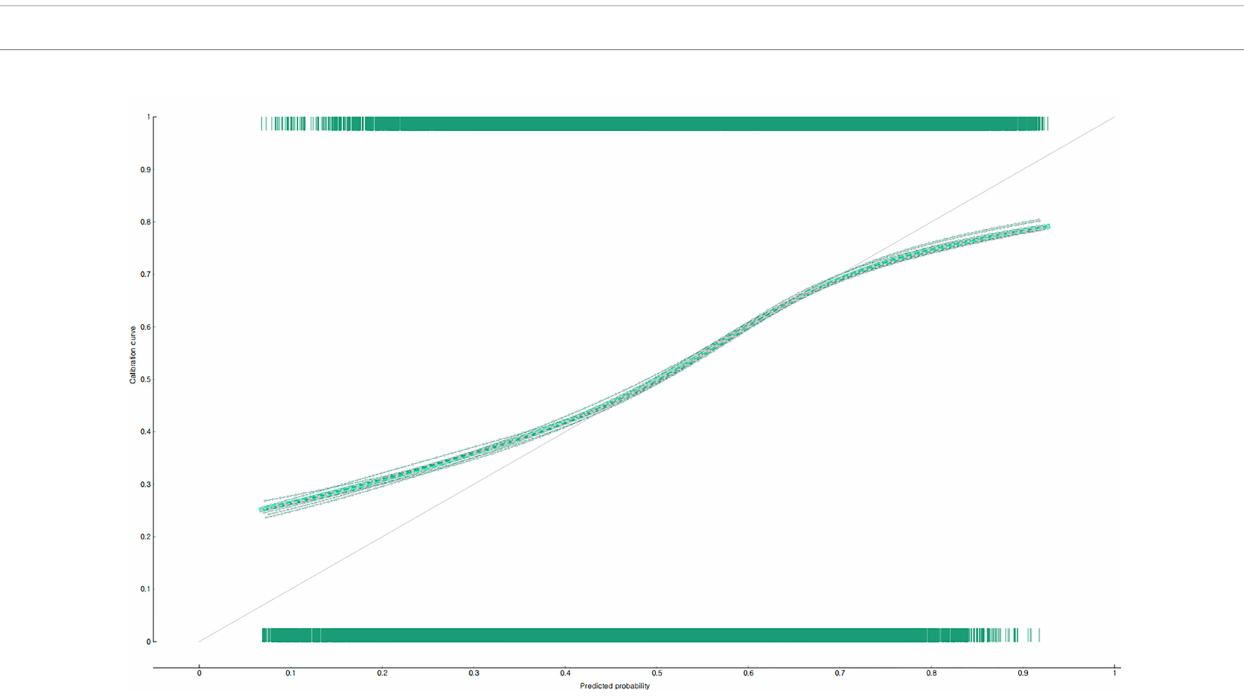
FIGURE 3 | Prediction performance of the nomogram for predicting the non-utilization of fundus examination in South Korean diabetic patients: calibration plot.